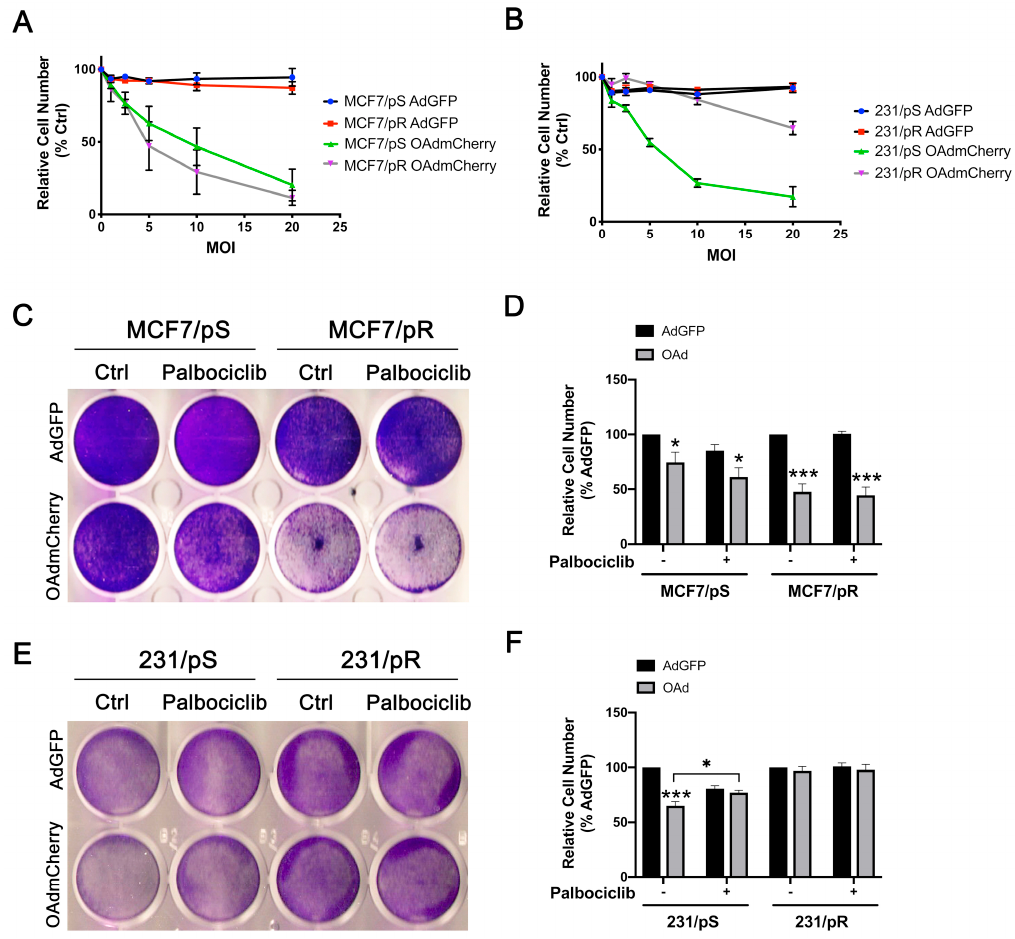
Figure 2. ER + and ER − breast cancer cell lines exhibit di ff erent cytotoxicity in response to the Ad5 / 3-delta24 modified to express the mCherry protein (OAdmCherry). ( A , B ) Cells were infected with adenovirus expressing green fluorescent protein (AdGFP) or OAdmCherry at the indicated multiplicity of infection (MOI) for 48 h. Cell cytotoxicity was assessed by crystal violet staining. OAd-mediated cytotoxicity was calculated by measuring the absorbance of solubilized dye at 590 nm and is expressed as percent (%) cell number relative to AdGFP vehicle-treated cells. The results shown are from one experiment. Three technical replicates were used to measure dye absorbance. ( C , E ) Cells were infected with a replication-deficient adenovirus expressing the green fluorescent protein (AdGFP) or the Ad5 / 3-delta24 modified to express the mCherry protein (OAdmCherry) at a multiplicity of infection (MOI) of five alone or in combination with palbociclib (500 nM) for 48 h. Cell survival was assessed by crystal violet staining. Representative staining for each cell line of three independent experiments performed is shown. ( D , F ) OAd-mediated cytotoxicity was calculated by measuring the absorbance of solubilized dye at 590 nm and is expressed as percent (%) cell number relative to their respective AdGFP vehicle-treated control. Error bars, ± SEM of four independent experiments. * p < 0.05; *** p < 0.001; compared to AdGFP unless otherwise indicated.